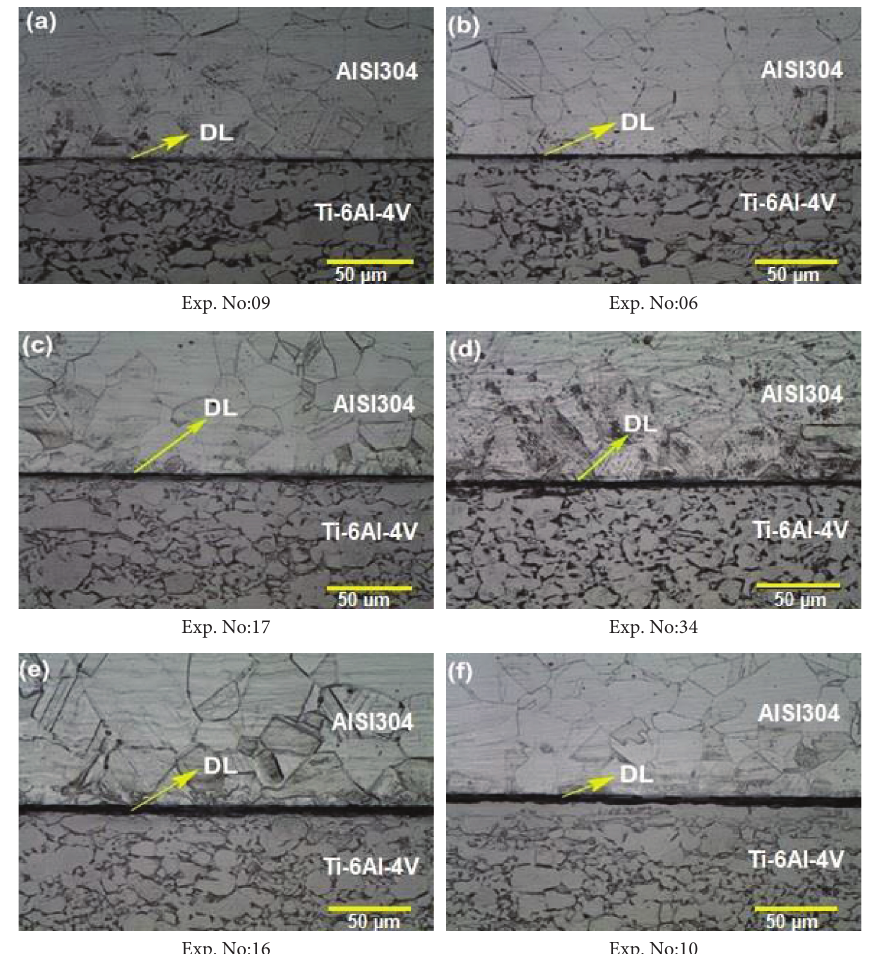
Figure 8: Optical micrographs of the interface region of Ti-6Al-4V/AISI304